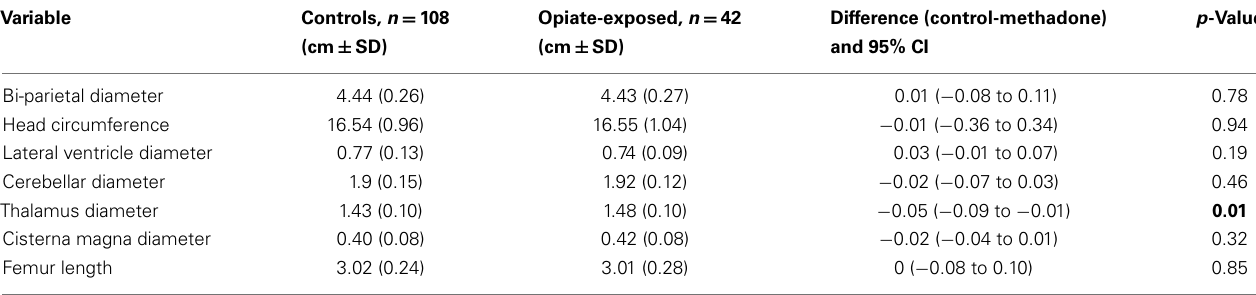
Table 2 | Comparison of FAS measurements between opiate – exposed fetuses and controls.